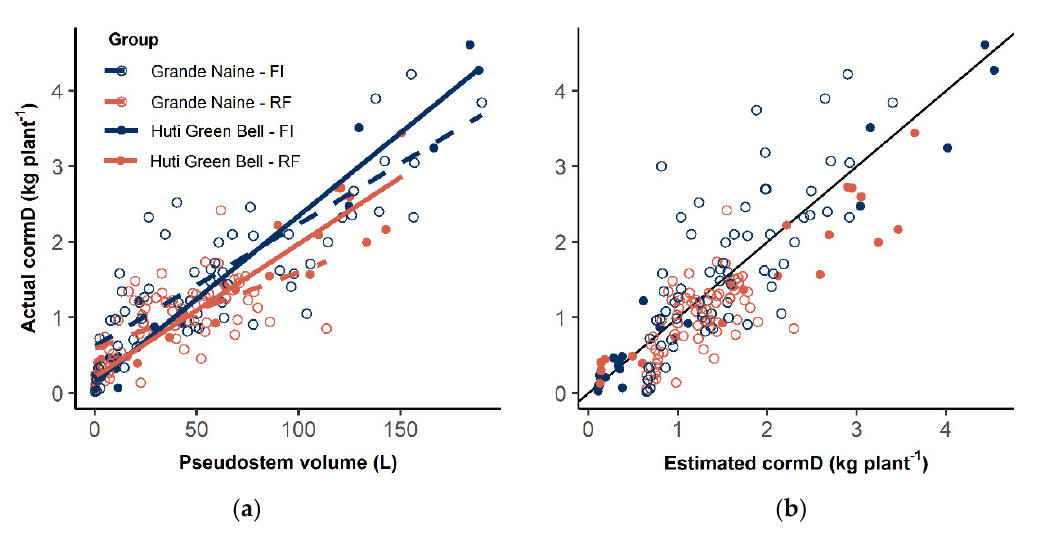
Figure 4. Corm dry matter (cormD, kg plant −1 ) models. ( a ) Actual cormD vs. pseudostem volume (V pseudo ) at destructive sampling (L) for Huti Green Bell (HG) and Grande Naine (GN). Regression models were specific models for treatment and cultivar as shown in Table 5; ( b ) Comparison of actual cormD vs. estimated cormD as obtained using the specific regression models for treatment and cultivar as shown in Table 5. FI notes full irrigation, RF notes rainfed.